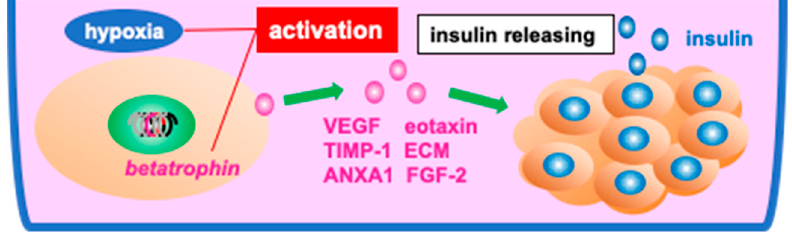
Figure 5. Supporting the function of cultured islet grafts for transplantation. Preculturing islet grafts with adipose tissue-derived mesenchymal stromal cells (ADMSCs) before transplantation enhances the insulin-releasing potential of the islet graft. ADMSCs support the islet in culture via the expression of and cross talk from vascular endothelial growth factor (VEGF), eotaxin, tissue inhibitor of metalloproteinase-1 (TIMP-1), extracellular matrix (ECM) components, annexin A1 (ANXA1), and fibroblast growth factor-2 (FGF-2). In addition, overexpression of betatrophin gene together with hypoxic culture conditions of islets graft with ADMSCs may enhance graft transplantation efficiency.